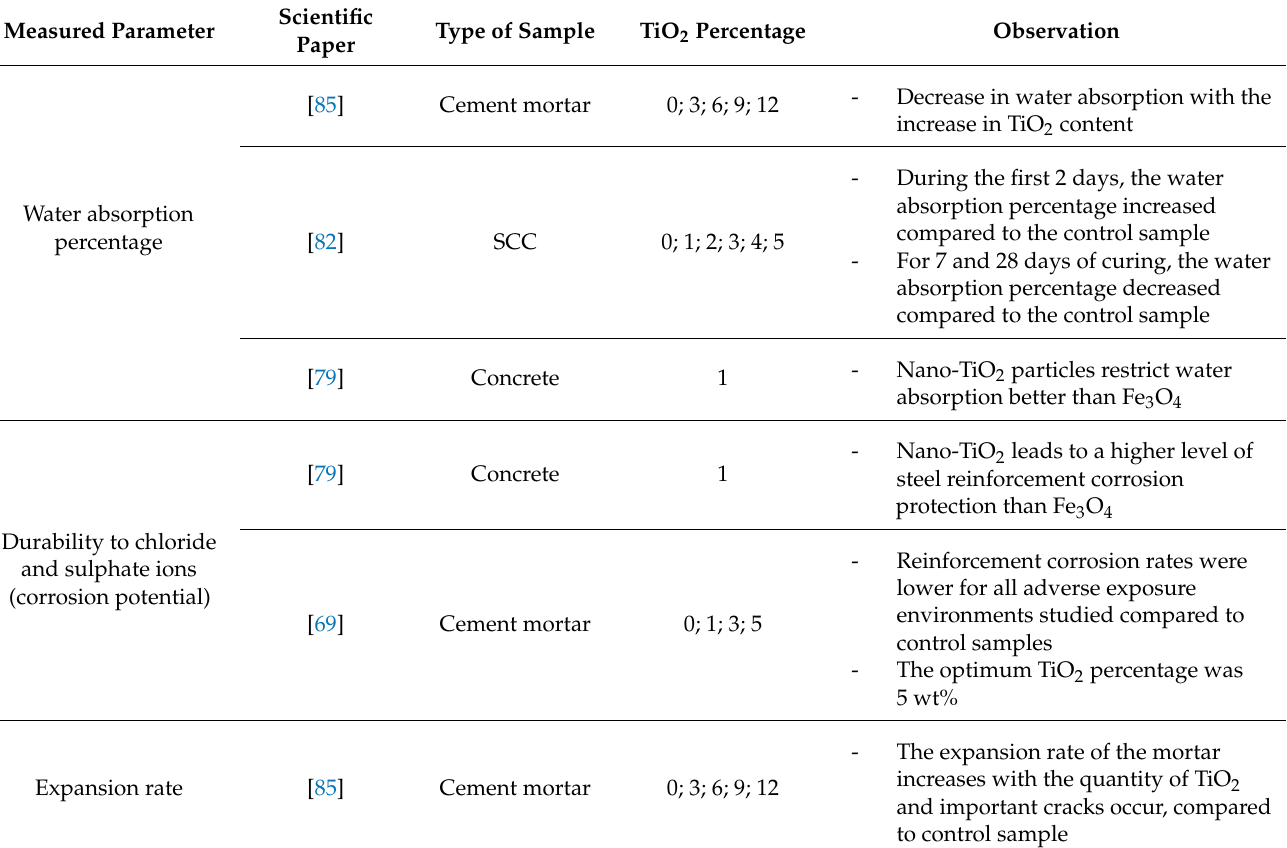
Table 10. Durability tests on TiO 2 —mortar/concrete